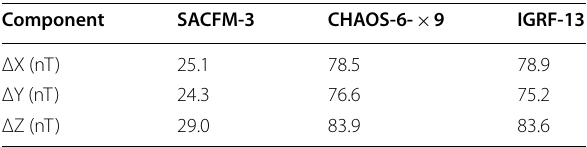
Table 3 The rms values of the differences between 113 survey data points and model predicted values over the period 2014– 2019